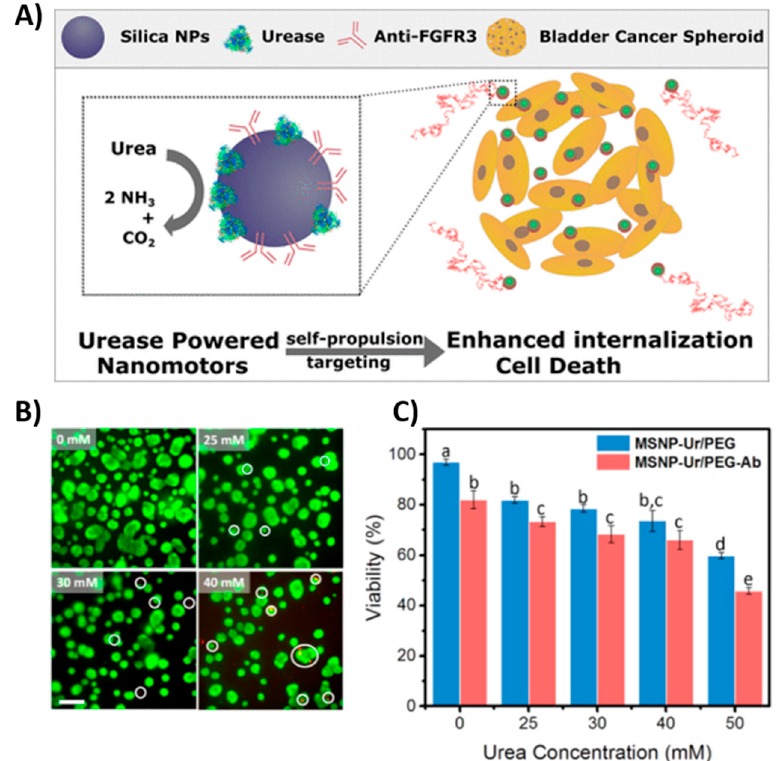
Figure 14. Targeting 3D bladder cancer spheroids with urease-powered nanomotors based on silica NPs. ( A ) Schematic illustration of targeting bladder cancer using antibody (Anti-FGR3) functionalized urease-powered silica NPs. ( B ) Live/dead assay of spheroids with nanomotors at 0-, 25-, 30-, and 40-mM urea after 4 h of incubation (scale bar 200 μ m). ( C ) Quantification of spheroids’